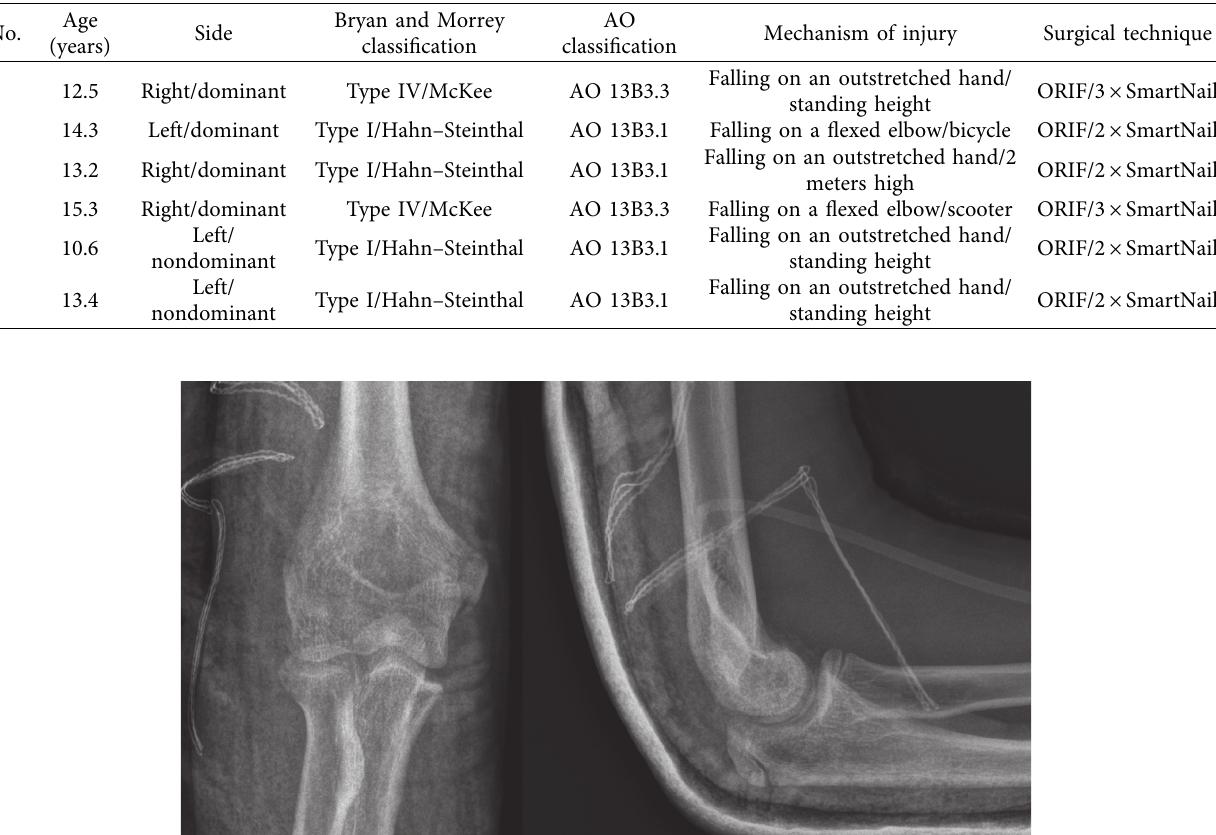
Figure 1: Patient number 4, preoperative X-rays, and CT scan. Type IV/McKee fracture according to Bryan and Morrey classification. Double arch sign is present on the lateral view. Table 1: The study group overview.